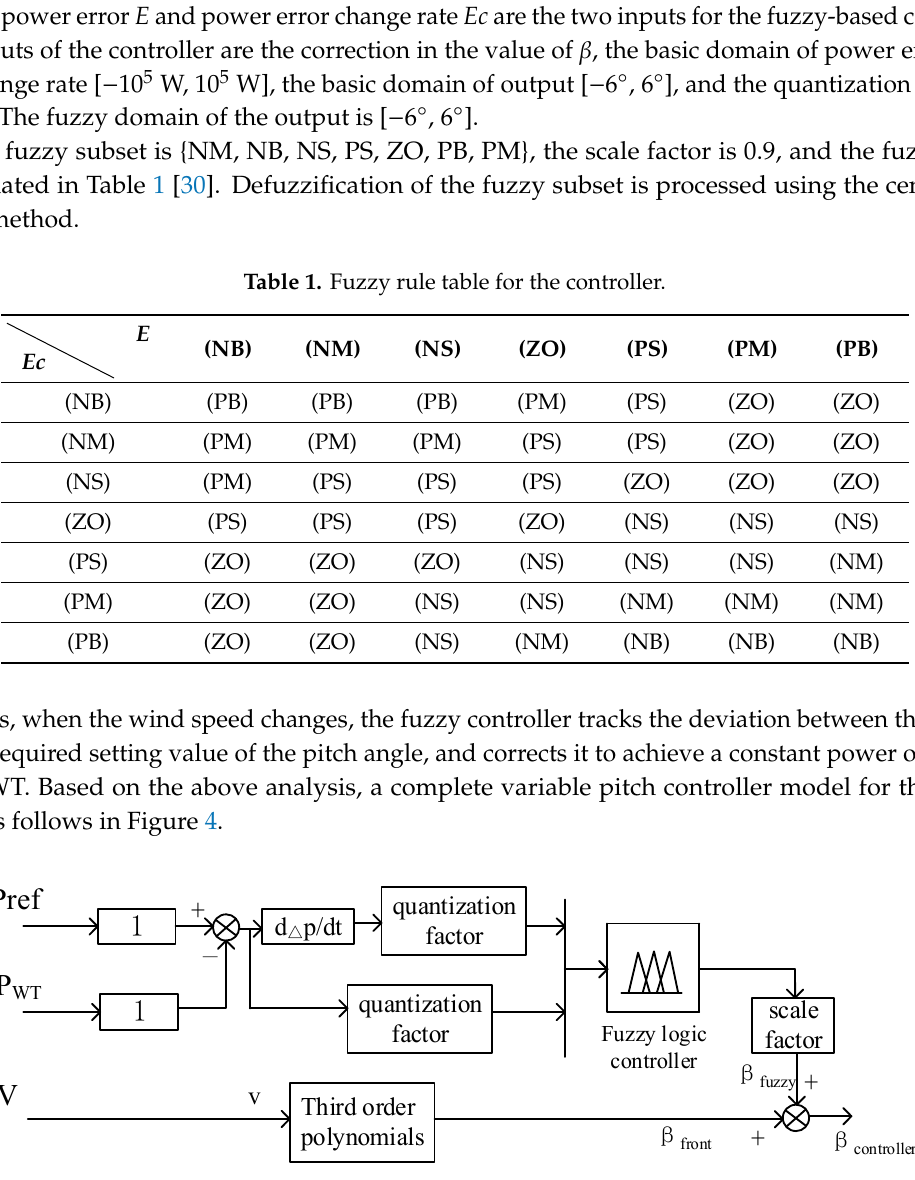
Figure 4. Fuzzy feedforward controller model for a wind turbine.